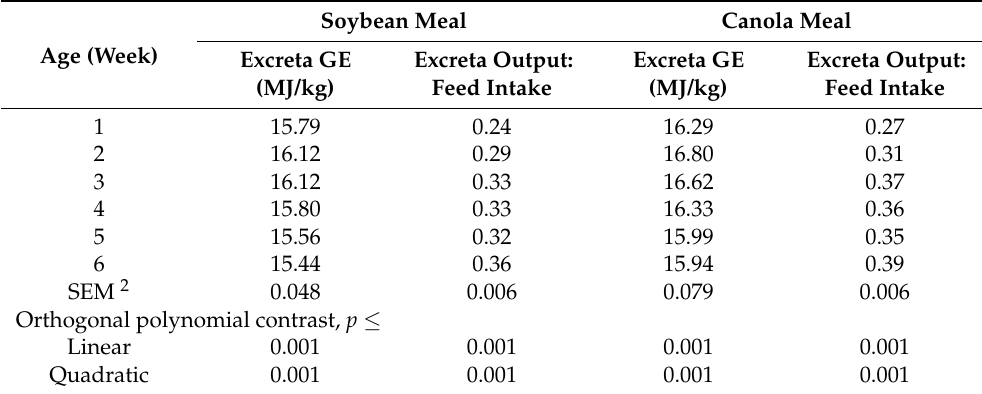
Table 5. Influence of broiler age on excreta gross energy (GE; MJ/kg DM) and excreta output:feed intake (kg:kg); in birds fed soybean meal and canola meal diets 1